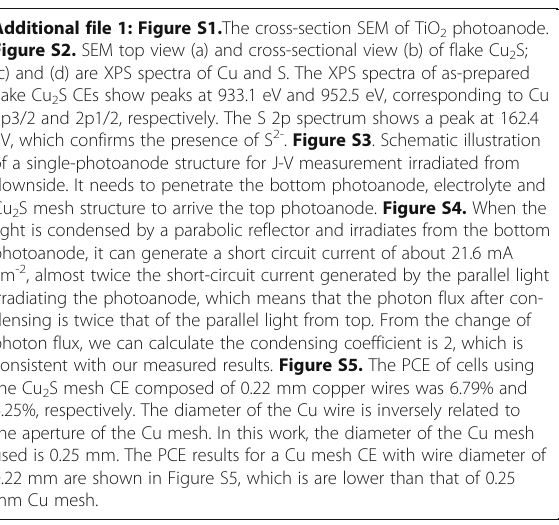
Additional file 1: Figure S1. The cross-section SEM of TiO 2 photoanode. Figure S2. SEM top view (a) and cross-sectional view (b) of flake Cu 2 S; (c) and (d) are XPS spectra of Cu and S. The XPS spectra of as-prepared flake Cu 2 S CEs show peaks at 933.1 eV and 952.5 eV, corresponding to Cu 2p3/2 and 2p1/2, respectively. The S 2p spectrum shows a peak at 162.4 eV, which confirms the presence of S 2- . Figure S3 . Schematic illustration of a single-photoanode structure for J-V measurement irradiated from downside. It needs to penetrate the bottom photoanode, electrolyte and Cu 2 S mesh structure to arrive the top photoanode. Figure S4. When the light is condensed by a parabolic reflector and irradiates from the bottom photoanode, it can generate a short circuit current of about 21.6 mA cm -2 , almost twice the short-circuit current generated by the parallel